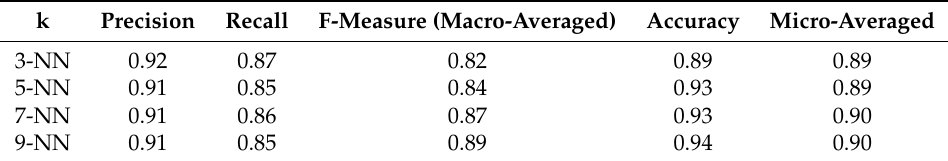
Table 6. Results of KNN showing Accuracy, Precision, Recall, F-measure against different parameters of the algorithm obtained using Weka tool.